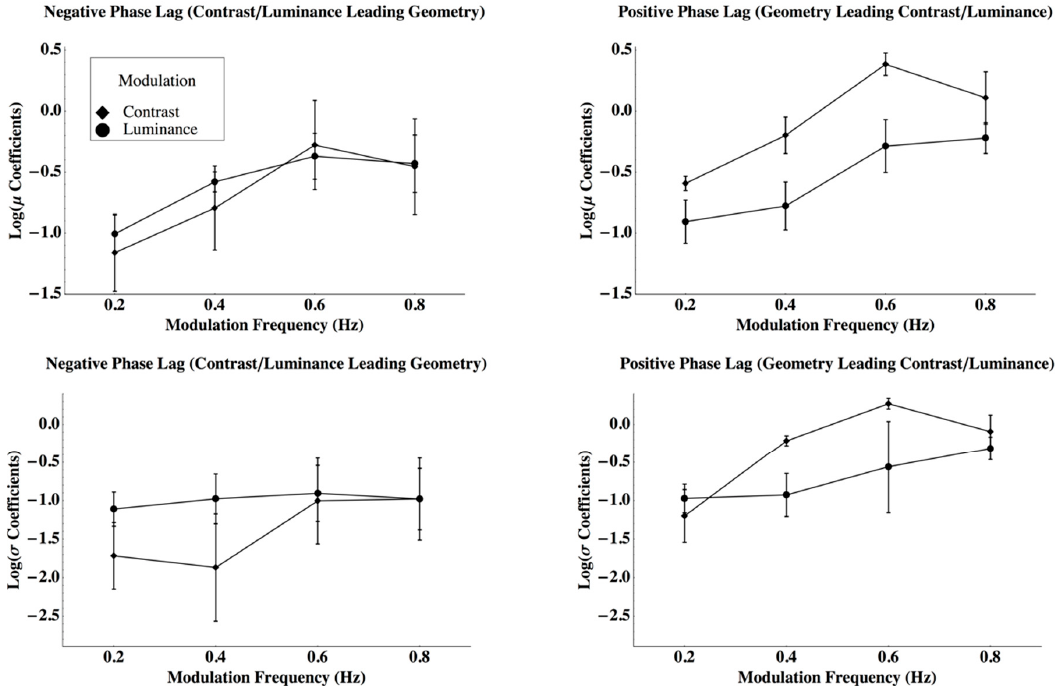
Figure 4. The parameters for the Laplace distributions represent response criteria to perceive a jump. The top row plots mean log ( µ ) and the bottom row mean log ( σ ) as a function of disparity modulation frequency with standard errors. The left column presents parameters for phase lags where contrast or average luminance disparities precede geometric disparity modulations and the right column where geometric modulations lead contrast or luminance modulations with standard errors.